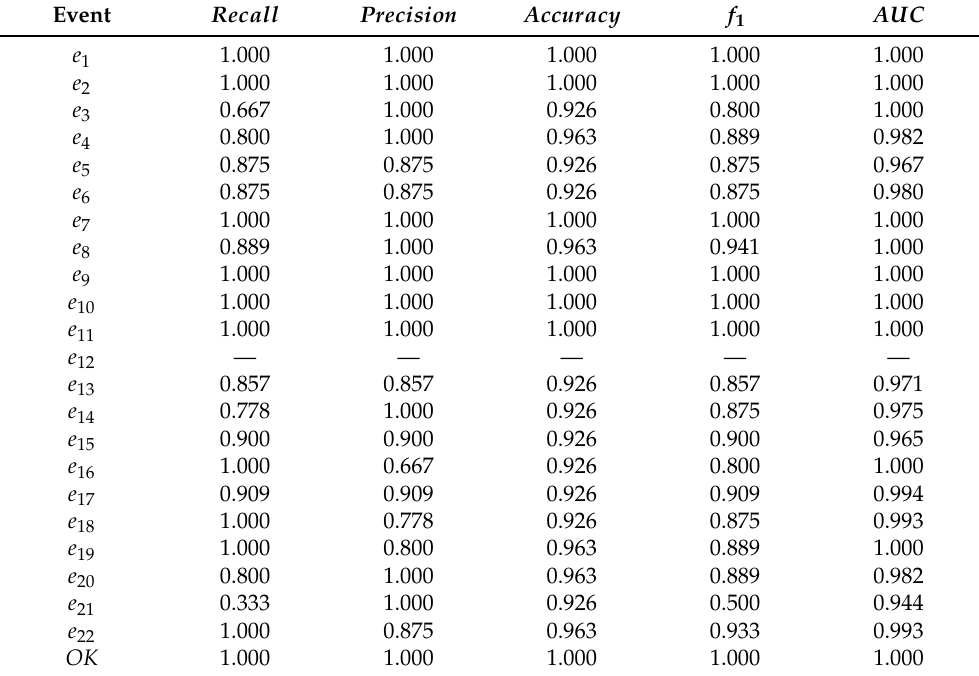
Table 8. Performance results of the proposed ANN model in a test dataset.